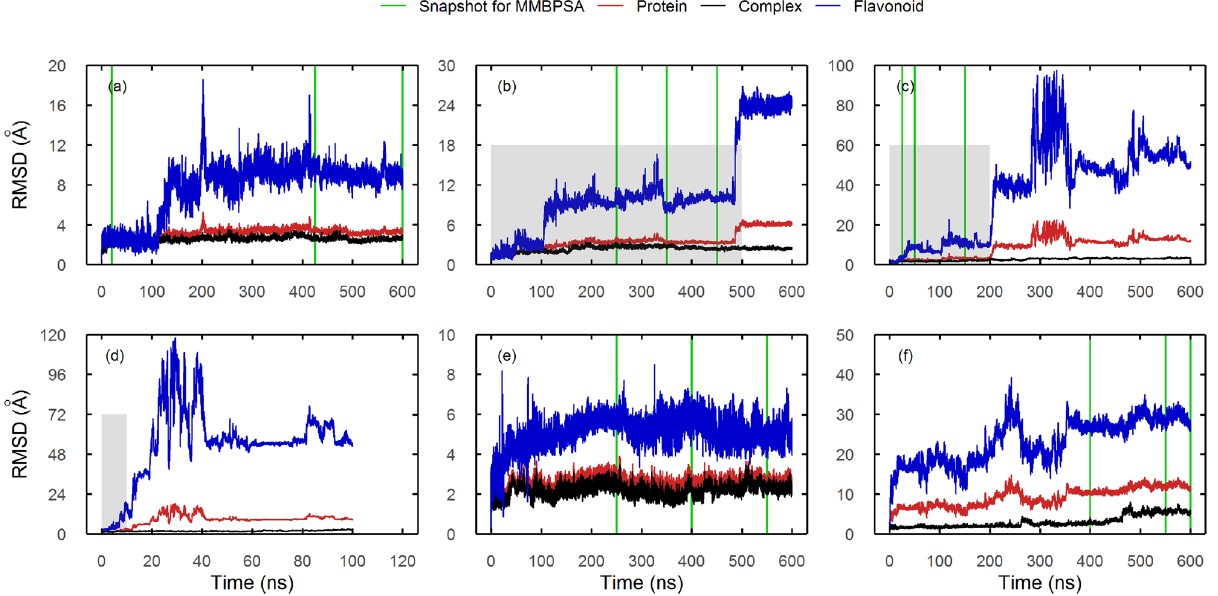
Figure 3. RMSD plots of flavonoid-M PRO selected ligands along molecular dynamics simulations. Positive and negative controls are also shown. As negative control only remained associated during the first 10 ns, MD was not extended. RMSD of the protein, complex and flavonoid ligand is shown in red, black and blue, respectively. Green vertical lines reflect snapshots taken for further analysis with MMPBSA methods. The grey box indicates residence time (RT, time in which the ligand is interacting with the protein). In plots without a grey box, the ligand never detaches from the protein. SBS : ( a ) Dorsilurin E, ( b ) euchrenone a11 (detaches at 500 ns), ( c ) X77 (positive control, detaches at 200 ns), ( d ) TDZD-8 (negative control, detaches at 10 ns). In the SBS, the second lowest RMSD and fluctuations within RT pertained to dorsilurin E (< 5 Å during the first 100 ns, < 16 Å during all the RT, with exception of some spikes), which suggest stable binding. DS : ( e ) sanggenol O. CS : ( f )